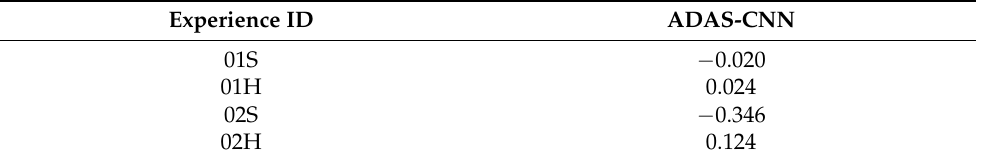
Table 3. Correlation analysis between ADAS activations and facial